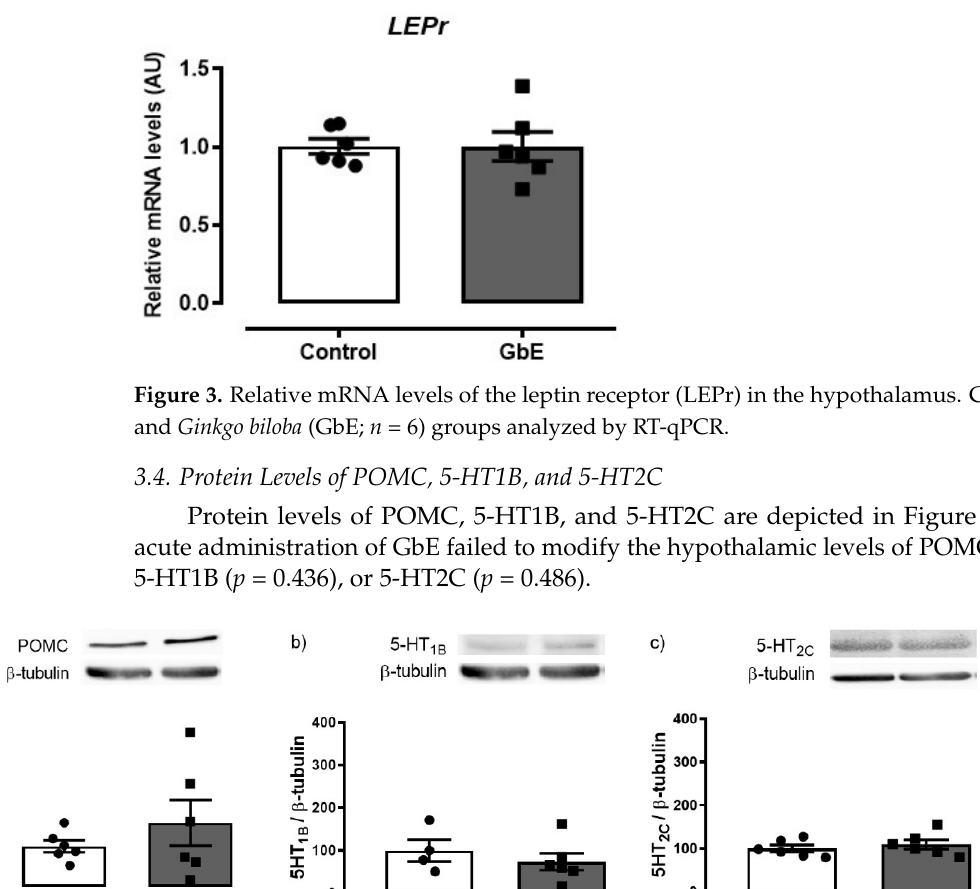
Figure 4. Hypothalamic protein expression. POMC ( a ), 5-HT1B ( b ), and 5-HT2C ( c ) of control ( n = 4–6) and Ginkgo biloba (GbE; n = 6) groups.